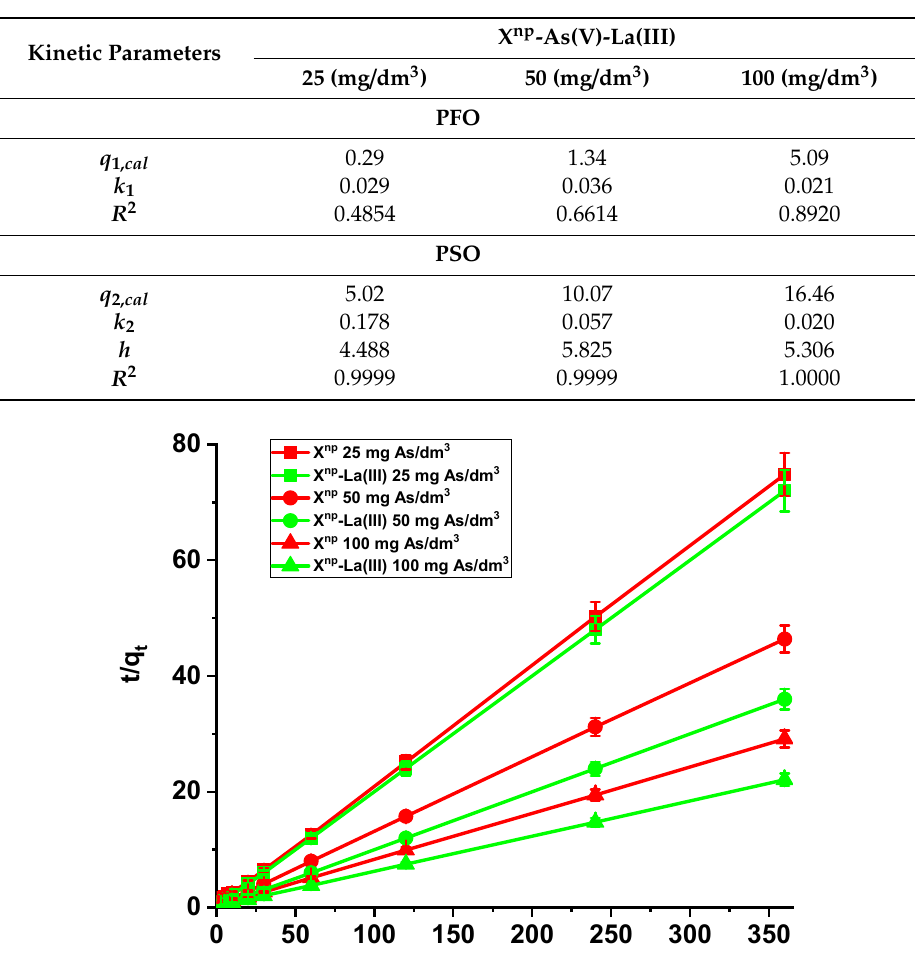
Table 5. Kinetic parameters of arsenic(V) adsorption on X np -La(III). Kinetic Parameters